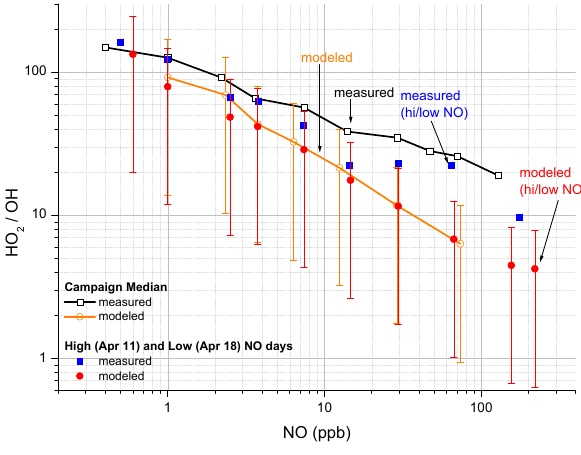
Fig. 4. The HO 2 /OH ratio as a function of NO. For graphical pur- poses, all of the HO x ratios are binned based on ranges of NO con- centrations. We used the following bins: 0–1ppb, 1–2ppb, 2–3ppb, 3–5ppb, 5–10ppb, 10–20ppb, 20–40ppb, 40–100ppb, and 100– 200ppb. Each circle or square represents the median of each NO concentration bin. The predicted values from the model on a cam- paign median basis are shown as the orange line with open circles, whereas the median measured values from the entire campaign are shown as a black line with open squares. The closed red circles and closed blue squares are the modeled and measured HO x ratios, re- spectively, for the high and low NO days, 11 and 18 April. Note that the lines are not a fit through the symbols, but rather connect the symbols to help guide the